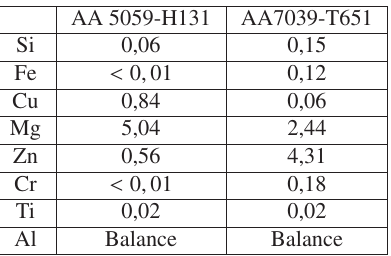
Table 1. Chemical